Question: In one sentence, what is this figure communicating?
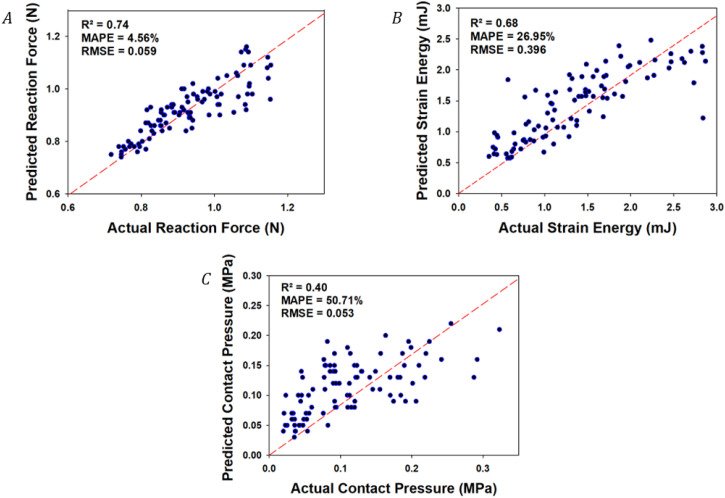
Answer: Performance of random forest regression models in predicting the biomechanical outcome: (a) reaction force, (b) strain energy, and (c) contact pressure. The x axis shows the actual values from the simulations, while the y axis shows the corresponding predicted values. Blue dots represent individual simulation data points, and the dashed red line represents the ideal surrogate model response, where predictions perfectly match the simulation results.